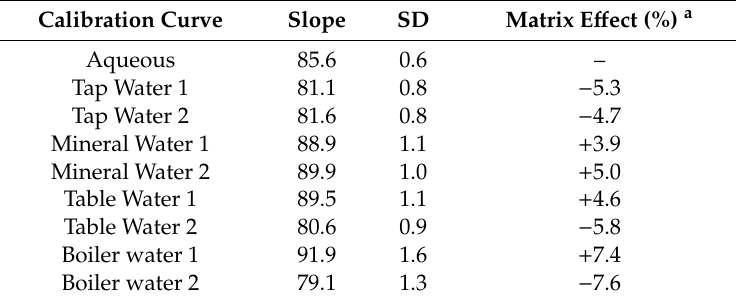
Table 1. Evaluation of the matrix e ff ect.